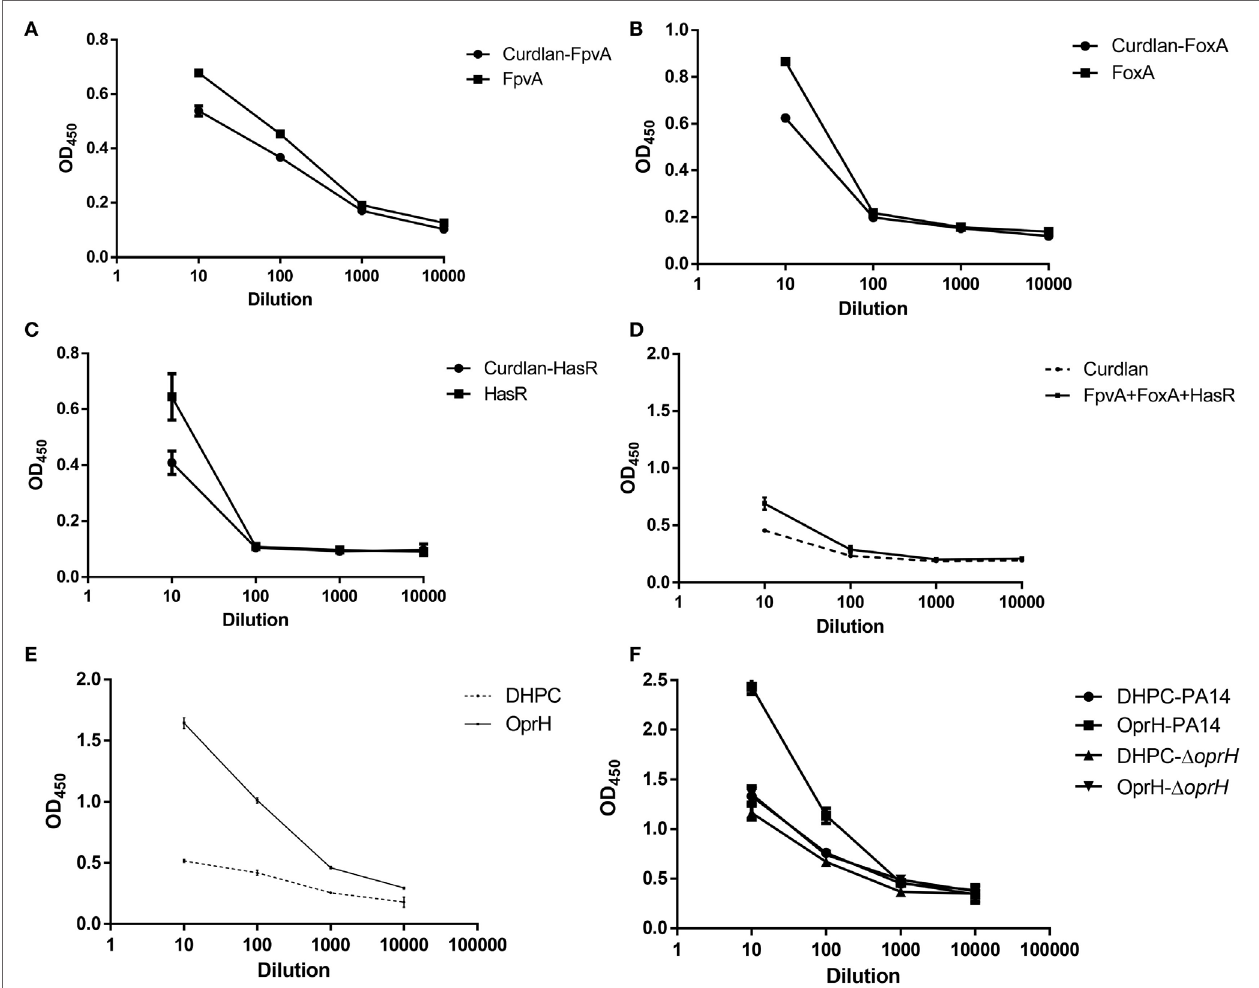
FigUre 5 | Enzyme linked immunosorbent assay (ELISA) of iron uptake proteins or OprH. (a–D) FpvA, FoxA, HasR, or mixture of iron uptake proteins were used to coat plates. The ELISAs were conducted using sera from mice immunized with each of the iron uptake proteins or the combination of these proteins with curdlan or curdlan alone. (e) Sera from mice immunized with the refolded OprH or DHPC alone with curdlan were tested for antigen-specific IgG levels by ELISA with plates coated with OprH. (F) ELISA of the whole bacterial cells. The cells of PA14 or the Δ oprH mutant were coated on an ELISA plate. Sera from mice immunized with refolded OprH or DHPC alone with curdlan were tested for the levels IgG that can bind to the cells by ELISA. Each point is the average of duplicates using pooled sera from five to seven mice, and error bars are